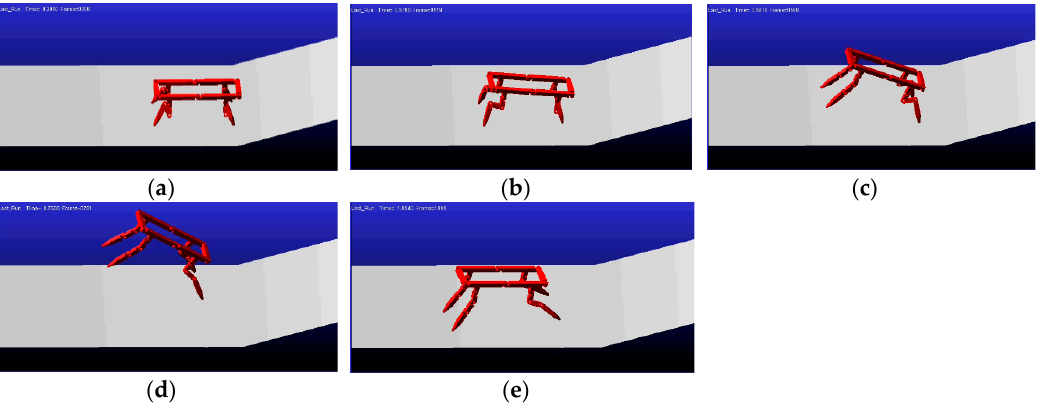
Figure 10. The simulation of the Origaker II without expandable trunk in Adams. ( a ) The robot is in the initial posture; ( b ) The front legs kick the ground; ( c ) The hind legs expand; ( d ) The robot jumps into the air; ( e ) The robot falls on the ground.